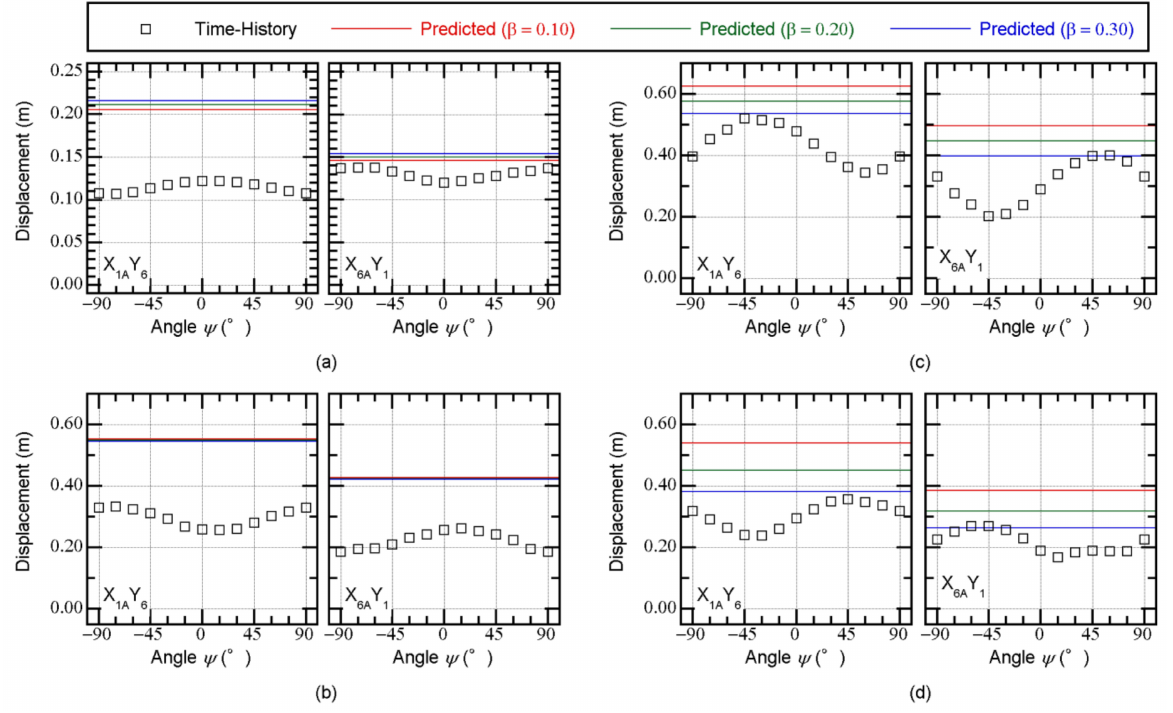
Figure 30. Peak displacement at isolators for various angles of incidence of seismic input (Model-Tf44): ( a ) UTO0414; ( b ) UTO0416; ( c ) TCU; ( d )